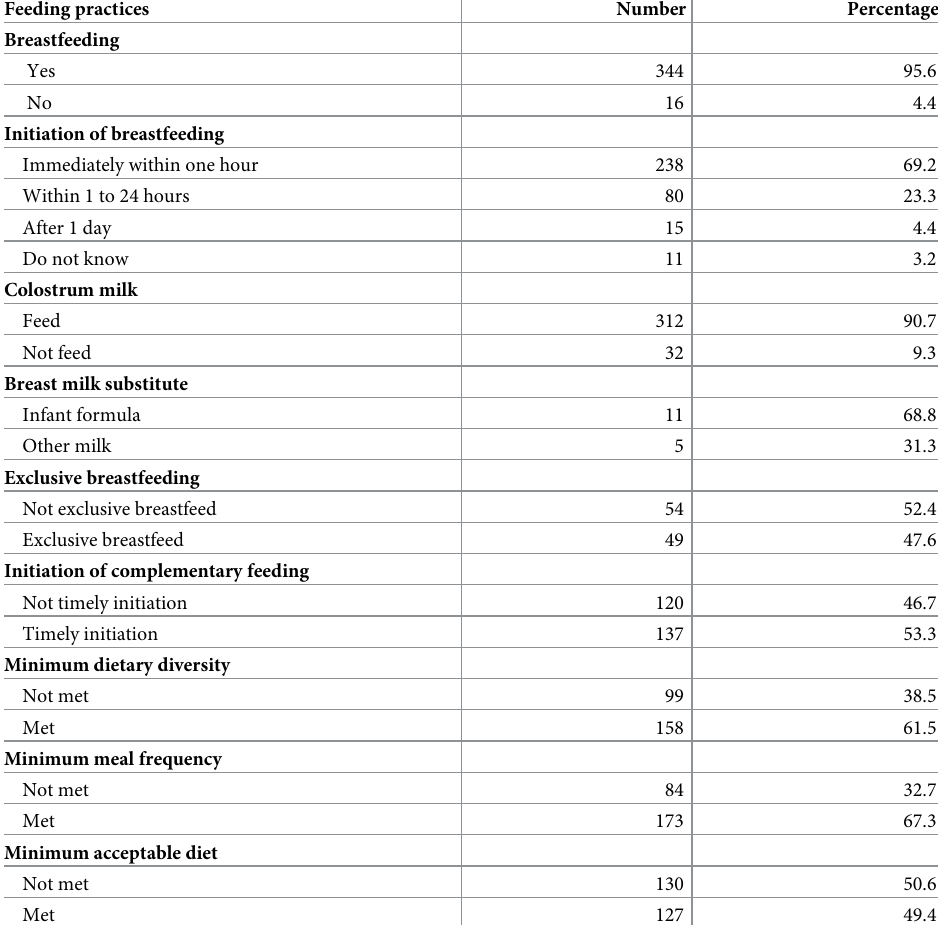
Table 3. Distribution of participants by their child feeding practices.